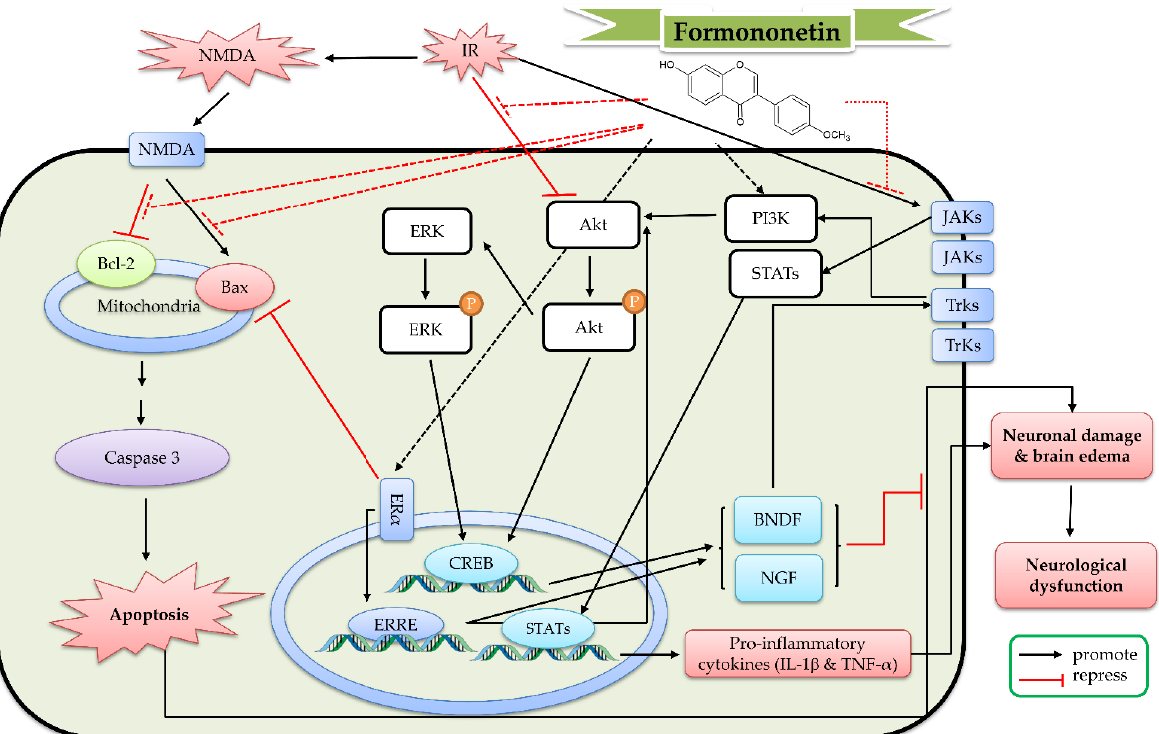
Figure 8. The protective effects of formononetin against cerebral ischemia reperfusion (IR). Akt, protein kinase B; Bax, Bcl-2-associated X protein; Bcl-2, B-cell lymphoma 2; BDNF, brain-derived neurotrophic factor; CREB, cAMP response element-binding protein; ERK, extracellular-signal- regulated kinase; ERRE, estrogen-related receptor response element sites; ER α , estrogen receptor α ; IL-1 β , interleukin-1 β ; JAKs, Janus kinases; NGF, nerve growth factor; NMDA, N-methyl-D-aspartate; PI3K, phosphoinositide 3-kinase; STATs, signal transducer and activator of transcriptions; TNF- α, tumor necrosis factor α , Trk, tyrosine kinase receptors. 8. The Protective Mechanism of Equol, O-DMA, and Other Metabolites against Cere- bral IR According to many pharmacokinetic and metabolic reports, isoflavone glucuronides and sulfates are the main metabolites of isoflavones in human plasma. As for the free aglycone metabolites of isoflavones, dihydrogenistein, dihydrodaidzein, and dihydro- glycitein are the intermediate metabolites of genistein, daidzein, and glycitein in plasma. Genistein and daidzein are the intermediate metabolites of biochanin A and formo- nonetin. The end-products of genistein and biochanin A are HPPA, 6′ -hydroxy-O-DMA, and p -ethyl-phenol. The end-products of daidzein and formononetin are O-DMA, S-equol, 3-hydroxy-equol, and 6-hydroxy-equol. The end-products of glycitein are 6-methoxy equol and 5′ -methoxyl-O-DMA. In addition, some hydroxylated compounds at the 3′ -, 6- , or 8-position are also considered as end metabolites of these above isoflavones [73 – 78]. However, these metabolites do not necessarily have the pharmacological activities of these parent isoflavones. For example, isoflavone glucuronides, S-equol, 6-hydroxy-equol, and O-DMA also possessed ERβ activities, as did the parent isoflavones. However, the ERβ activities of isoflavone glucuronides, 6-hydroxy-equol, and O-DMA were weaker than their parent isoflavones [39,74]. The ERβ activity of S-equol is comparable to or even better than that of daidzein, while it is almost equivalent to that of genistein [133]. As for other metabolites, they may not be ERβ active ( p -ethyl-phenol), or their activities have not been reported. Hence, the related literature on the pharmacological activity of S-equol, O-